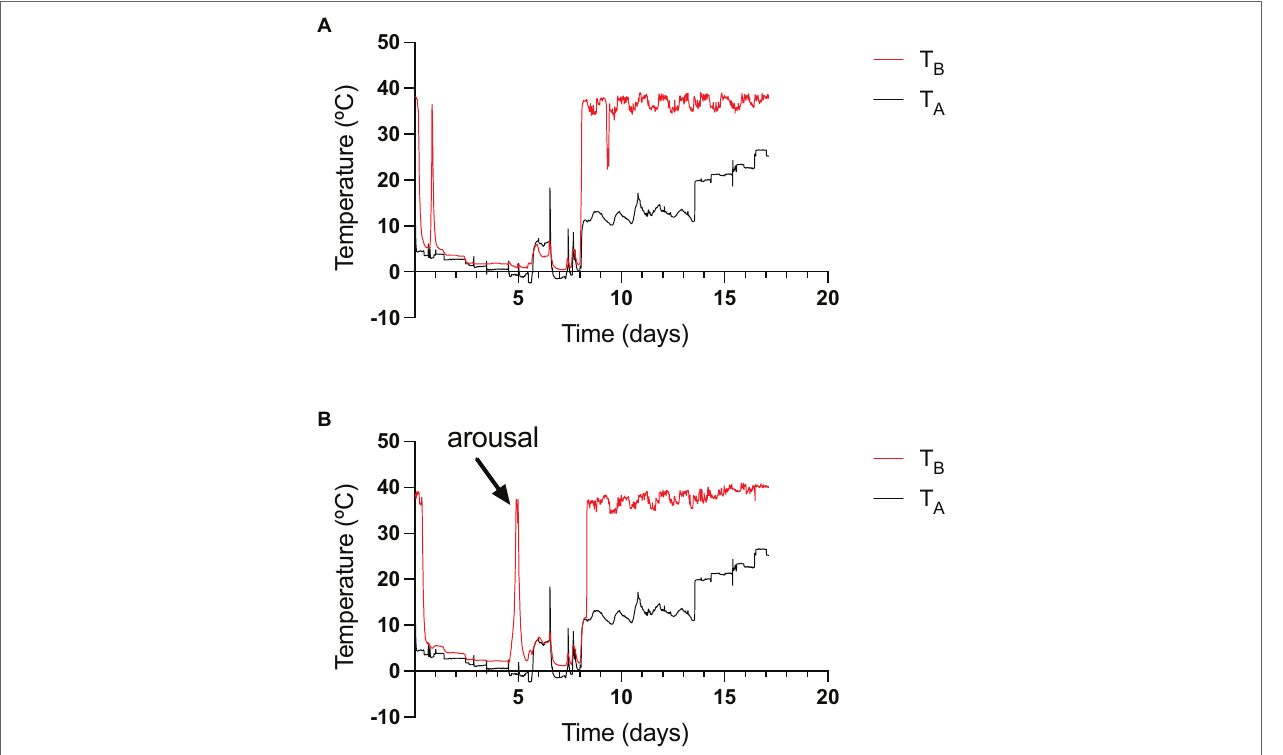
FIGURE 8 | The ramping experiment, where two D. gliroides ( A,B ; without food access), with intraperitoneal data loggers were gradually exposed first to diminishing temperatures from 5